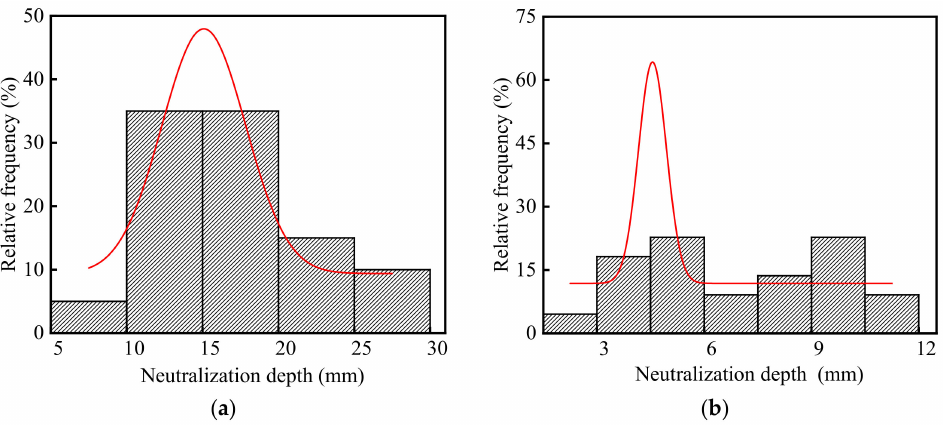
Figure 7. Frequency distribution histograms of concrete neutralization depth in the steelworks: ( a ) Ingot casting bay; ( b ) Billet bay.